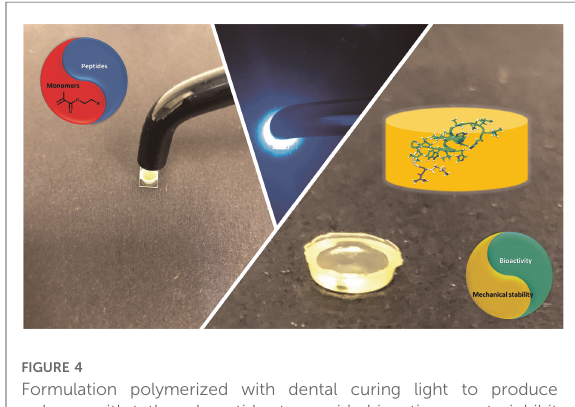
FIGURE 4 Formulation polymerized with dental curing light to produce polymer with tethered peptides to provide bioactive cues to inhibit bacterial activity and promote